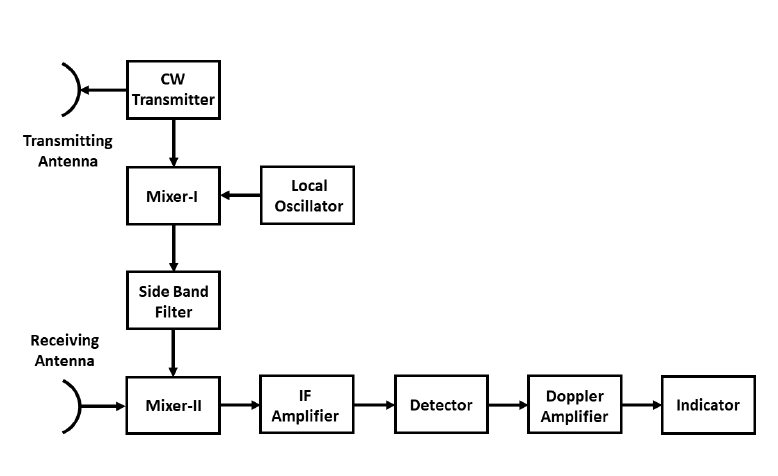
Figure 2. Block diagram of CW Doppler radar